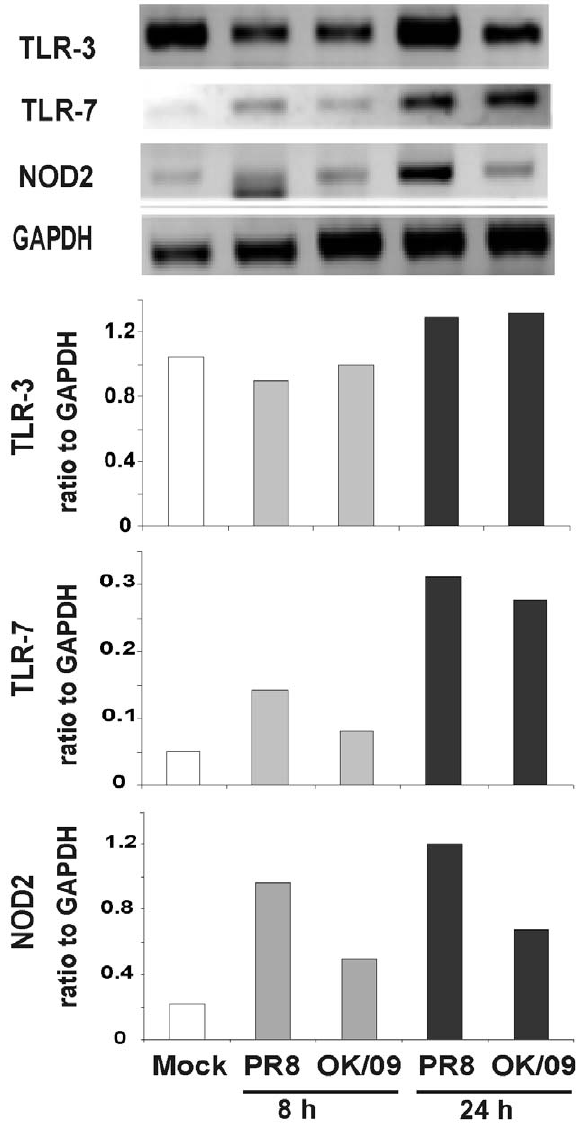
Figure 6. Pandemic OK/09 virus induces a similar TLR7 but diminished NOD2 mRNA expression compared to PR8 virus in human lung. Lung slices were exposed to 6 6 10 6 PFU/ml of PR8 and OK/09 for 8 h and 24 h. Relative end-point RT-PCR was used to determine mRNA expression. Transcript levels of Toll-like receptor (TLR) 3, TLR 7, and nucleotide-binding oligomerization domain 2 (NOD2) were normalized relative to GAPDH mRNA expression. Data are representative of 3 separate experiments.